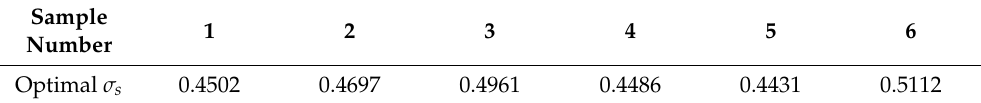
Figure 5. Fitting for the measured normalised surface impedance of six felt samples, ( a ) Sample 1, ( b ) Sample 2, ( c ) Sample 3, ( d ) Sample 4, ( e ) Sample 5, ( f ) Sample 6. Table 3. Optimal standard deviation obtained from the inverse characterisation on the six felt samples